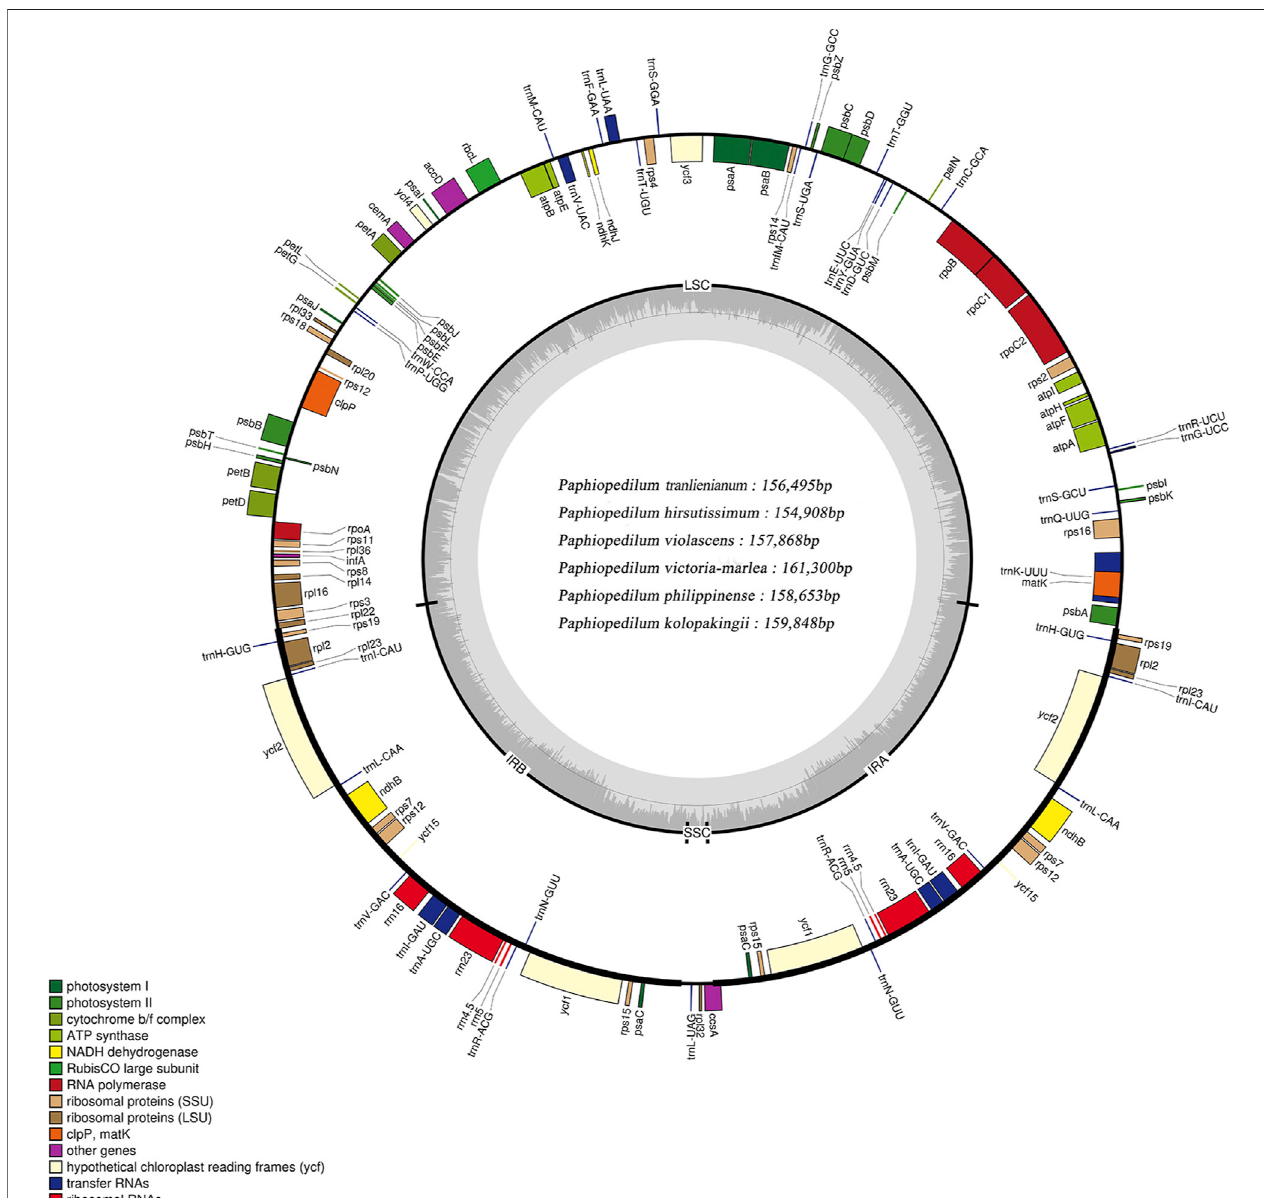
FIGURE2| Structure map ofthe Paphiopedilum chloroplastgenomeswith P.tranlienianum asreference.Genesdrawninsidethecirclearetranscribedclockwise, andthoseoutsidearetranscribedcounter-clockwise.Differentcoloredbarsindicategenesbelongingtodifferentfunctionalgroups.Largesinglecopy(LSC),smallsingle copy (SSC), and inverted repeats (IRA, IRB) are indicated. Area dashed darker gray in the inner circle indicates GC content, while the lighter gray area shows AT content of the genome. The intermediate gray line is 50% threshold